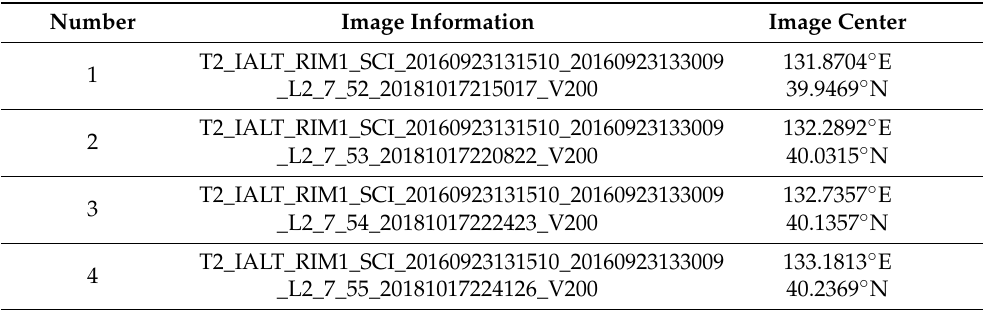
Figure 8. InIRA images of the ISWs in the Sea of Japan acquired from the same orbit at 13:15 on 23 September 2016, where panels ( a – d ) correspond to image data numbers of 52 through 55, respectively. Table 1. InIRA images of the ISWs in the Sea of